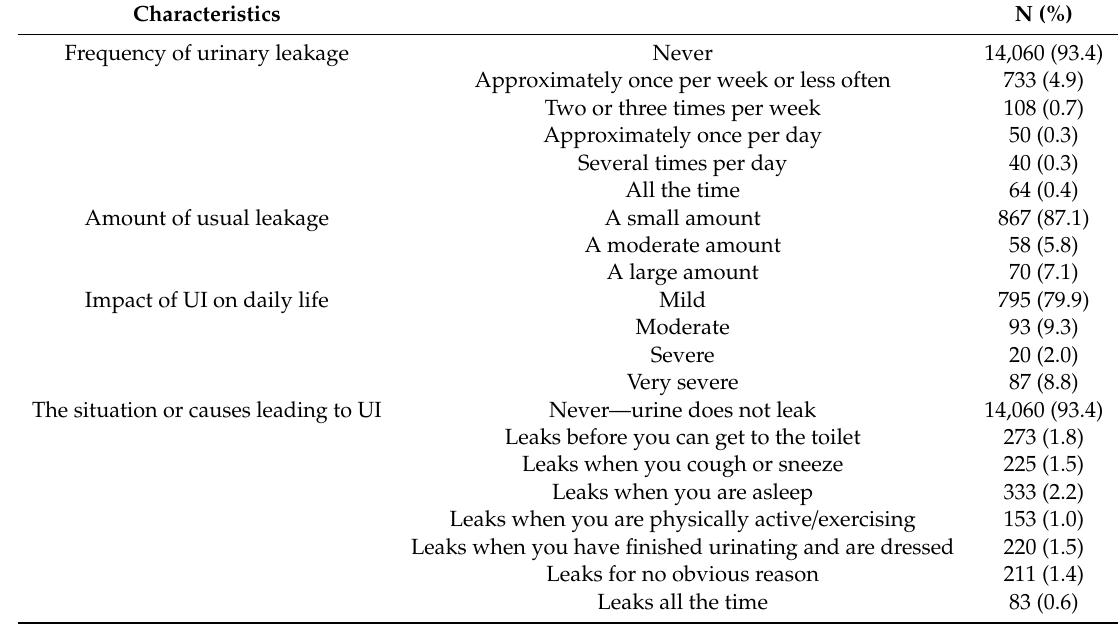
Table 3. Severity of